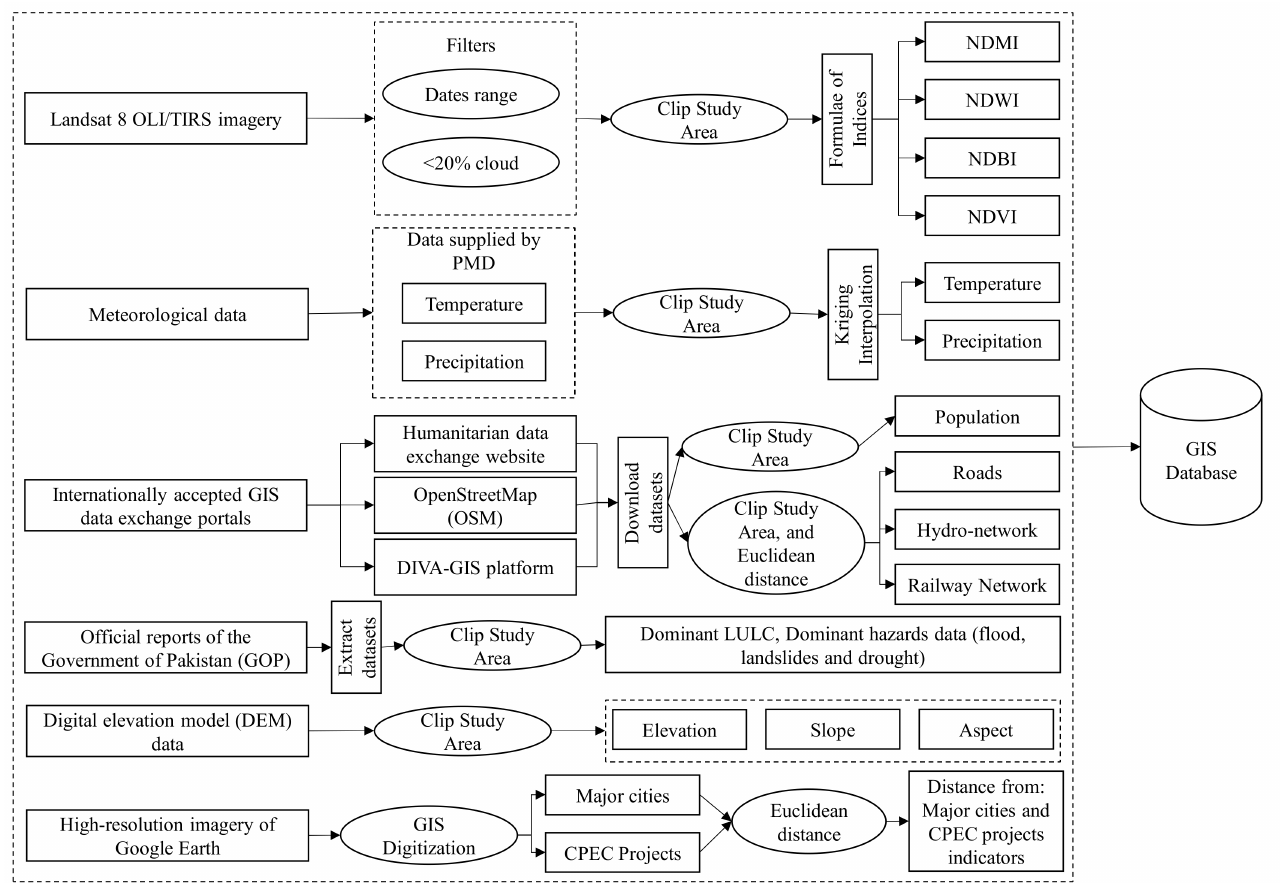
Figure 3. Technical flow adopted for the development of GIS database of eco-environment